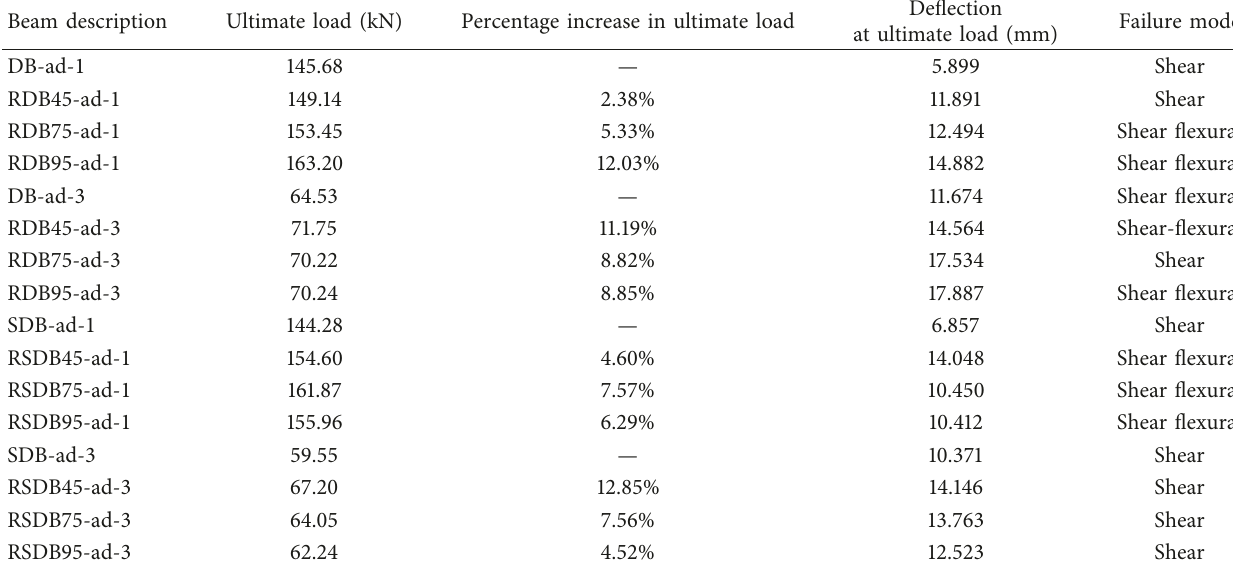
Table 6: Reloading test results of predamaged strengthened